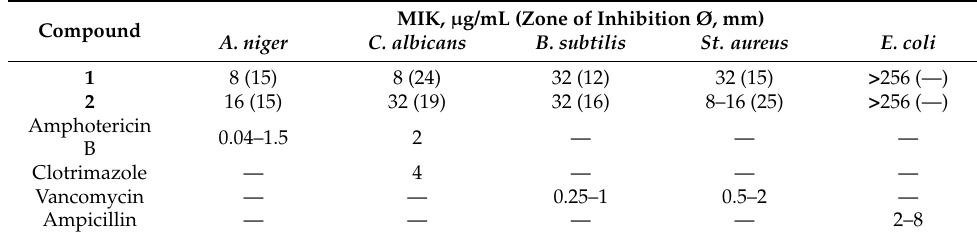
(Table 3). Spirocyclic 3-nitroisoxazoline 1 was more active against fungal cultures, while its bicyclic analogue 2 displayed similar activity against fungi and bacteria. Table 3. Antibacterial and antifungal activity of 3-nitroisoxazolines 1 , 2 . Compound